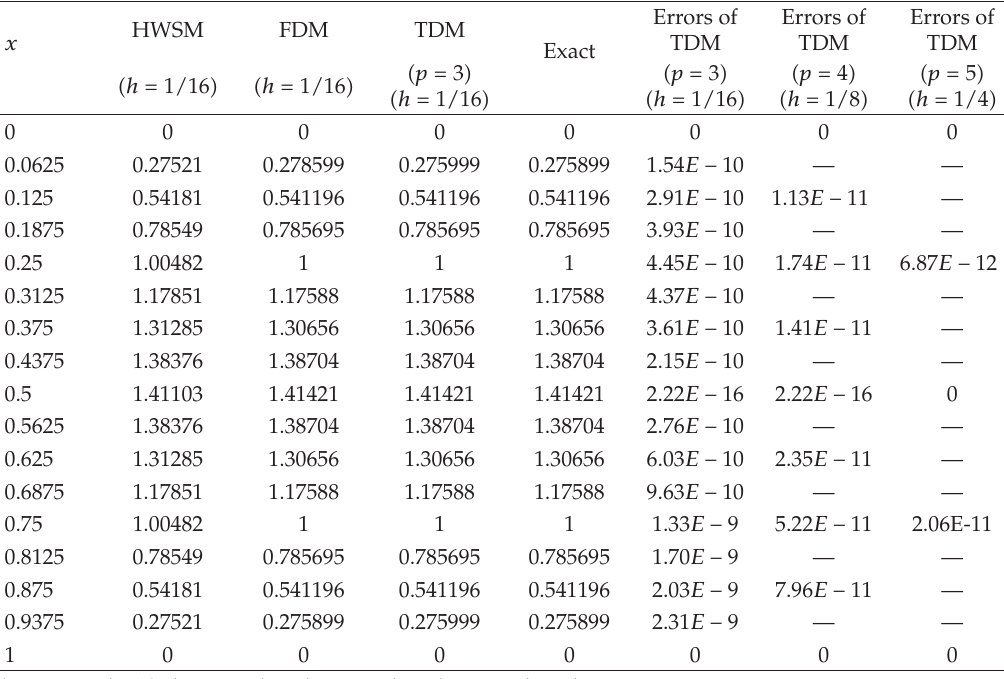
Table 2: Comparison of the first eigenvalue and solutions of Example 3.1 using Taylor’s decomposition method, exact values, and Table 4 from (cid:6) 9 (cid:7) , when n (cid:5) 0.